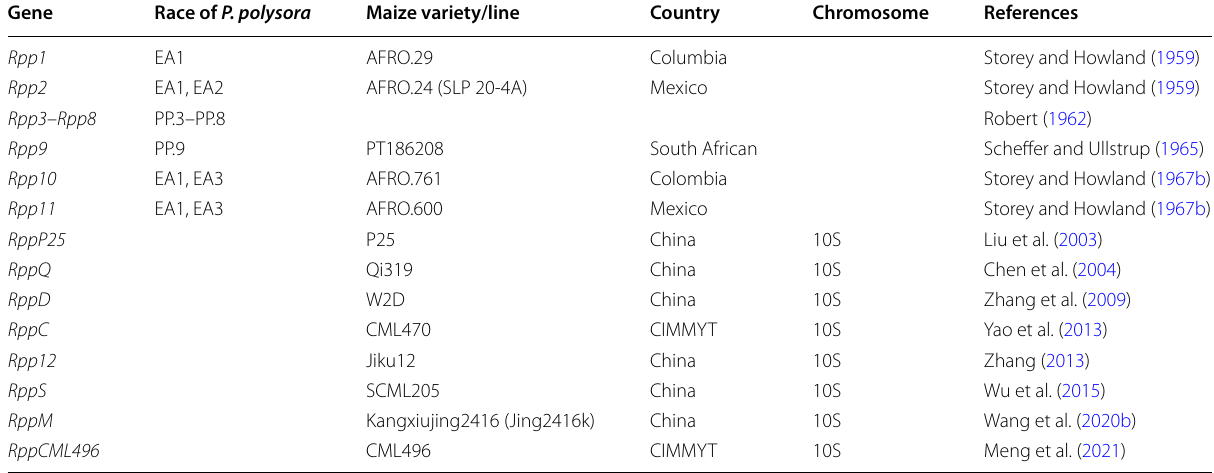
Table 1 Summary of SCR-resistant genes Gene Race of P.